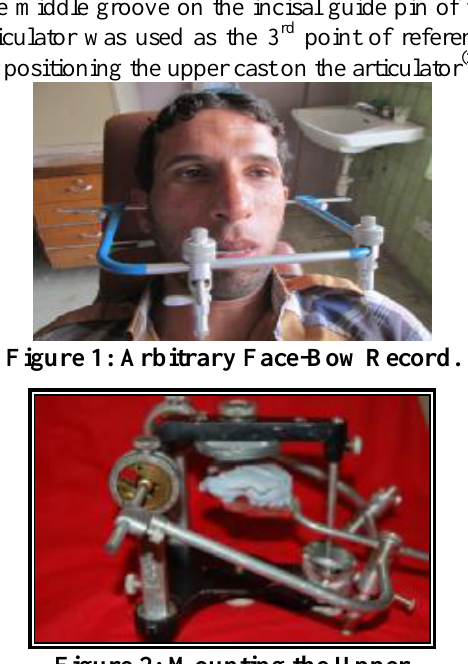
Figure 2: Mounting the Upper Cast Using the Hanau